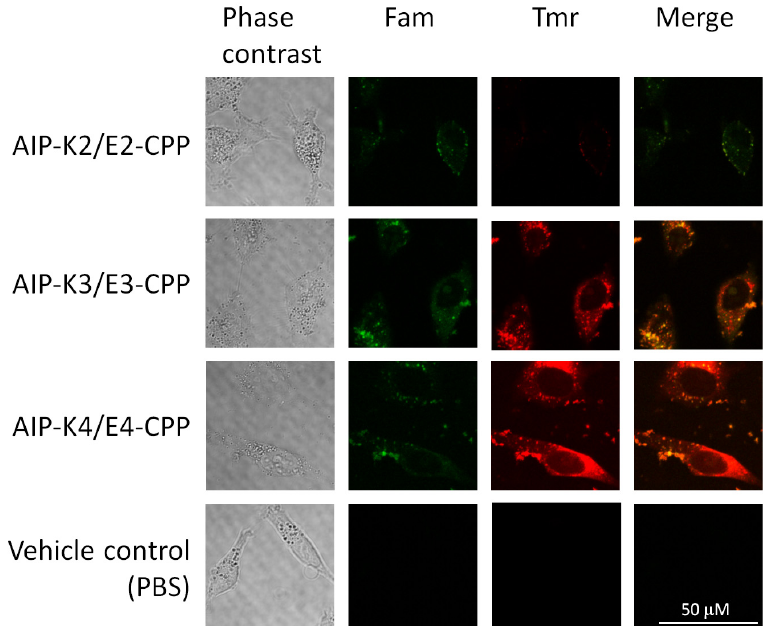
Figure 3. Confocal microscopy images of HeLa cells treated with Kn-/En-based 1:1 mixture. The cells were treated with 10 µM of the respective hybrids, AIP-K2/E2-CPP, AIP-K3/E3-CPP, and AIP- K4/E4-CPP, for 1 h. Fam and Tmr fluorescence signals were separately detected as green and red signals, respectively. Merged images are also presented on the right (yellow signal).